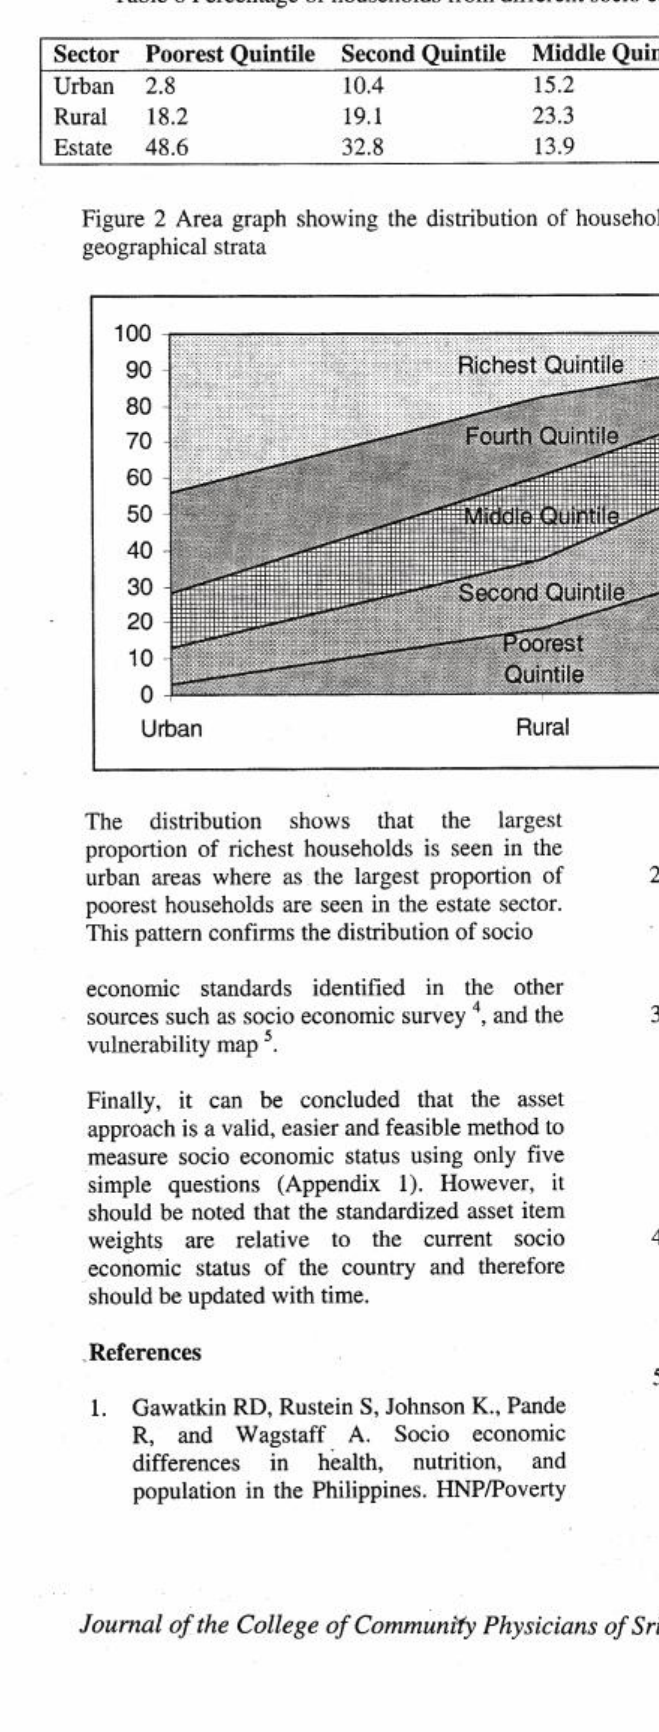
Table 6 Percentage of households from different socio economic quintiles across geographical strata